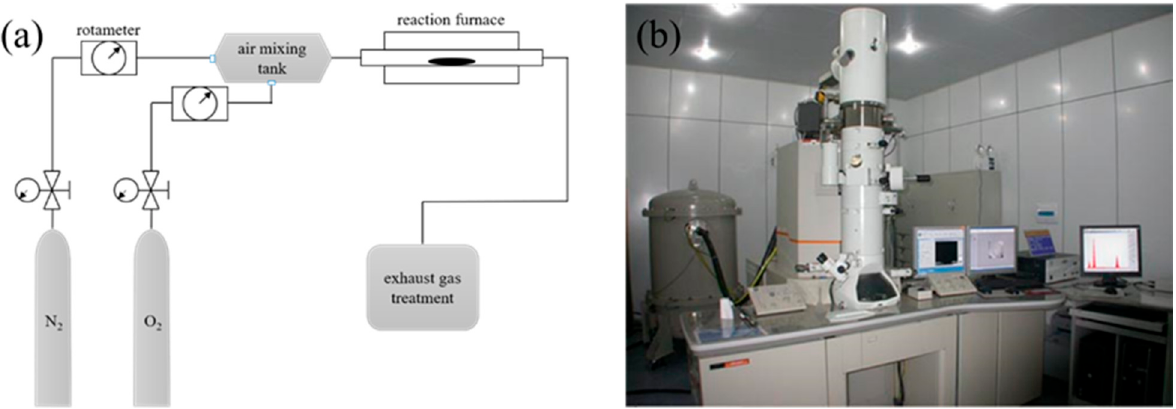
Figure 1. ( a ) Schematic diagram of fixed-bed catalytic oxidation device. ( b ) Field-emission high- resolution transmission electron microscope (JEM-2100F).